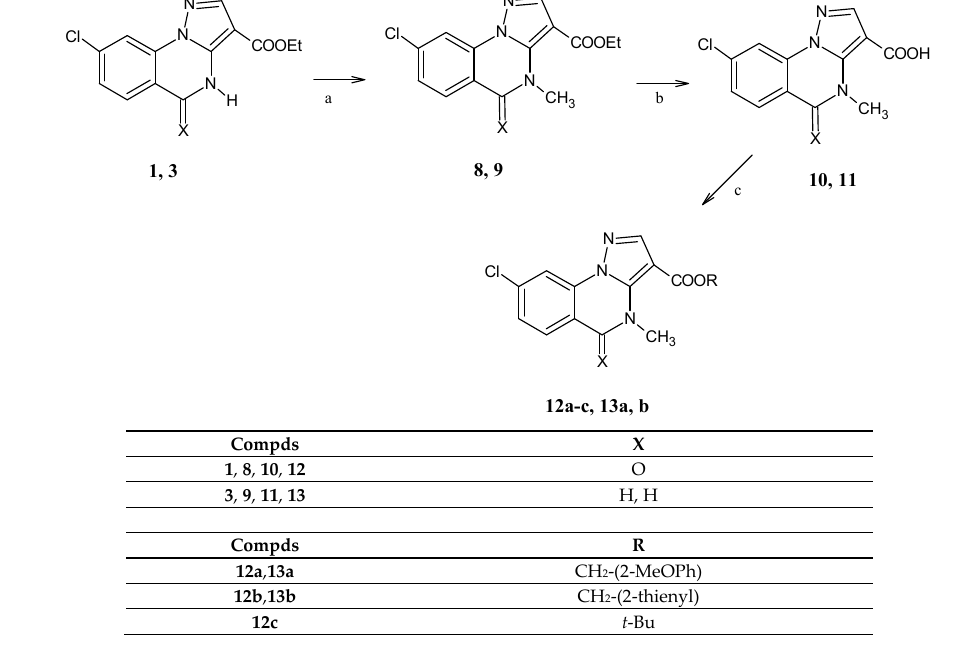
Scheme 2. Reagents and conditions: (a) DMF/K 2 CO 3 /MeI for 8 ; t BuOH/NaH/MeI for 9 ; (b)